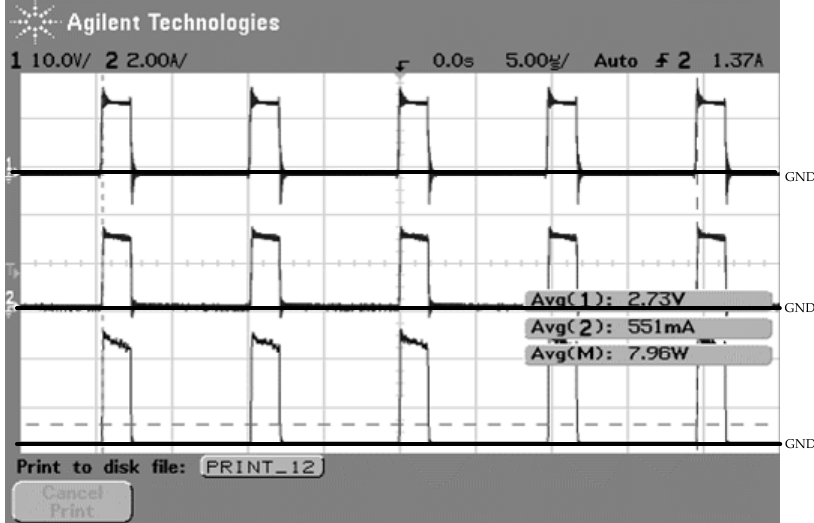
Figure 20. Output characteristics of proposed boost converter with f s = 100 kHz. ( Top Trace ) Output Voltage; ( Middle Trace ) Output Current; ( Bottom Trace ) Output Power.